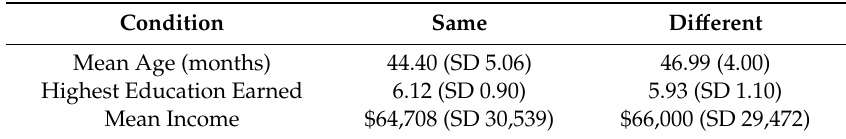
Table 1. Participants’